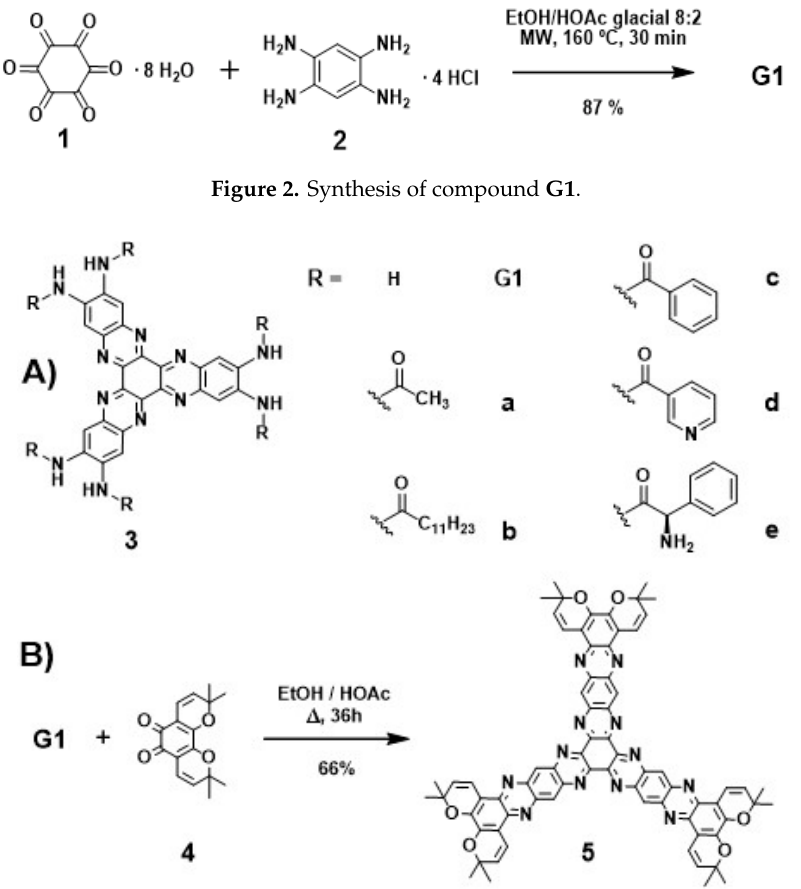
Figure 2. Synthesis of compound G1